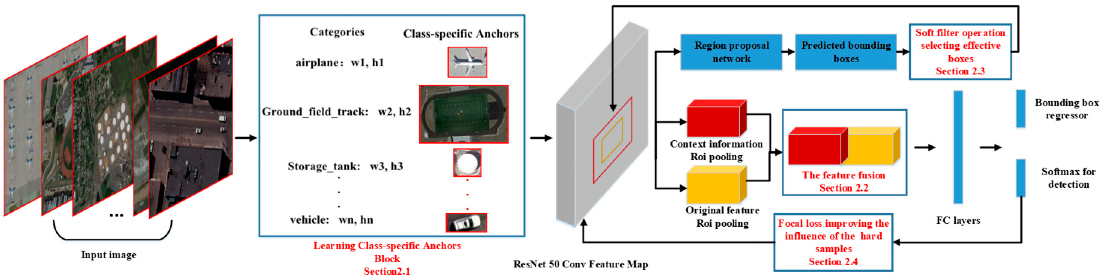
Figure 2. The architecture of the proposed class-specific anchor based and context-guided multi-class object detection method with convolutional neural network.